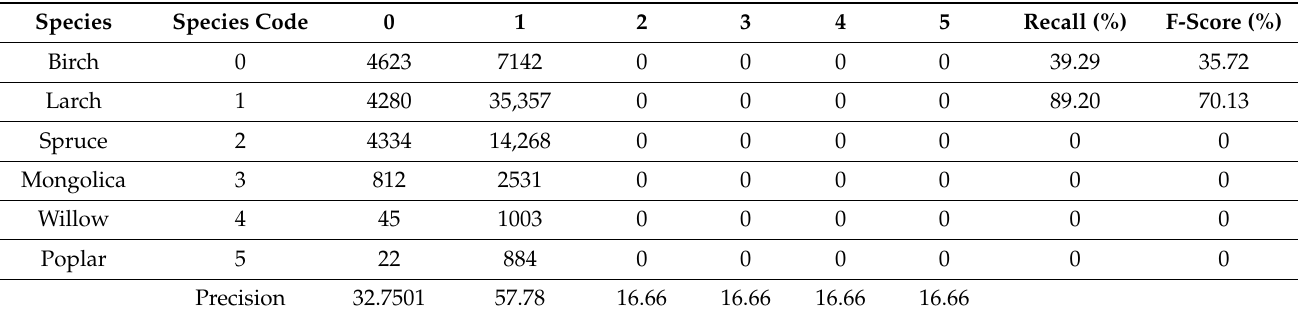
Table 4. The tree classification confusion matrix for tree species classification using ground truth (rows) compared to the SVM model species prediction (columns; numbered labels refer to species numbers shown in row labels).